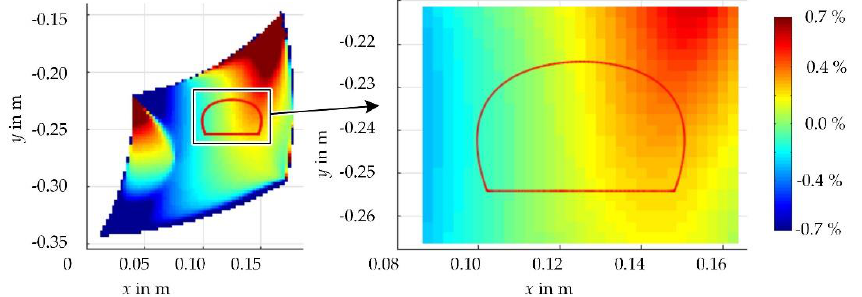
Figure 12. Error when using large ε instead of small ε for calculating the Jacobian in the manipulator’s